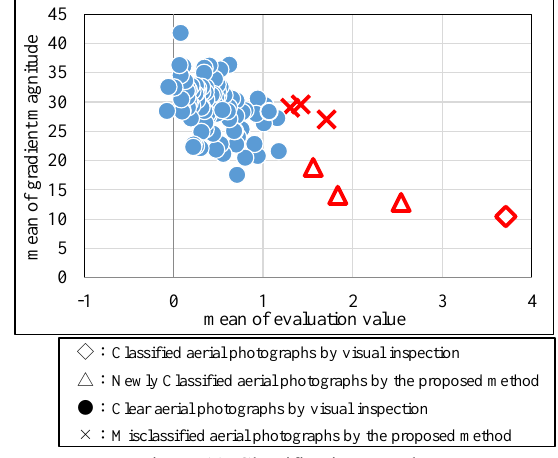
Figure 11. Classification Results